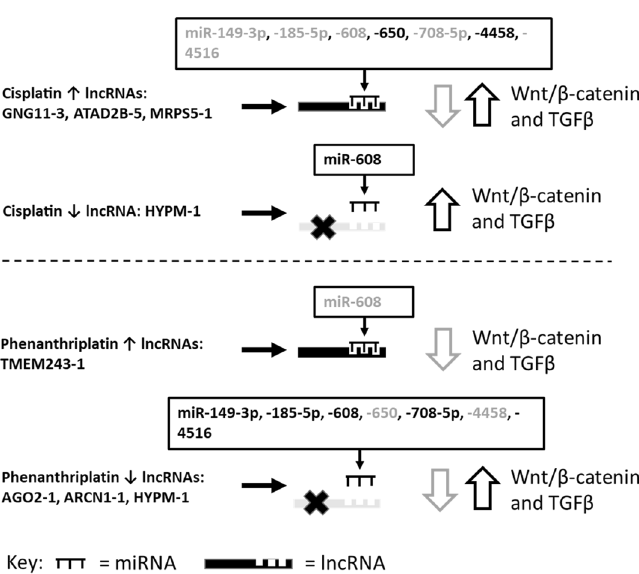
Figure 5. Potential modulation of Wnt/β-catenin and TGF-β signaling via cisplatin and phenanthriplatin regulation of lncRNAs and predicted miRNA binding partners in IMR90 cells. Key: Grey miR text = miRNA associated with downregulated Wnt/β-catenin and TGF-β signaling, Black miR text = miRNA associated with upregulated Wnt/β-catenin and TGF-β signaling, grey open down arrow = downregulated, black open up arrow =